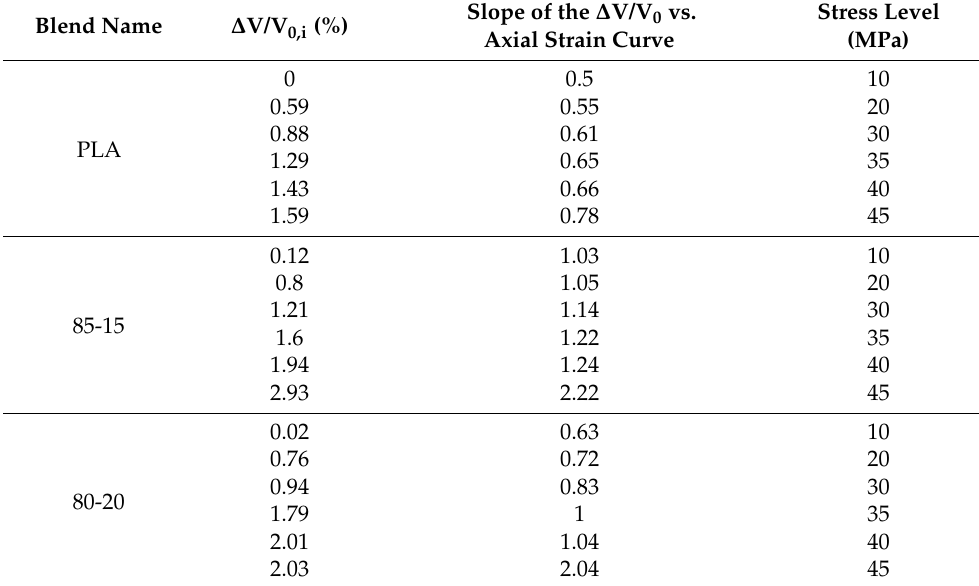
Table 3. Volume variation at time zero and the slopes of the ∆ V/V0 vs. the axial strain curve at different stress